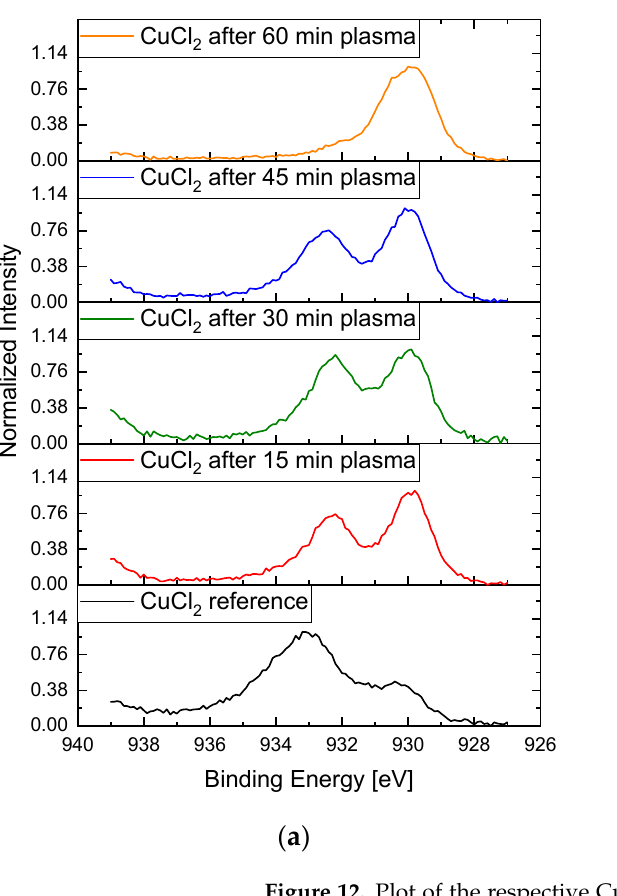
Figure 12. Plot of the respective Cu-2p 3 signal ( a ) of copper(II) chloride after 15 (red), 30 (green), 45 (blue), and 60 min (orange) treatment time at a low pressure with Varigon plasma compared to the reference (black). The stacking of these graphs clarifies the decrease in the left Cu 2+ signal and the increase in the Cu + signal with higher treatment times. The right picture shows a plot of the conversion of Cu 2+ to Cu + ( b ) at different treatment times, which illustrates a time-dependent reduction trend.